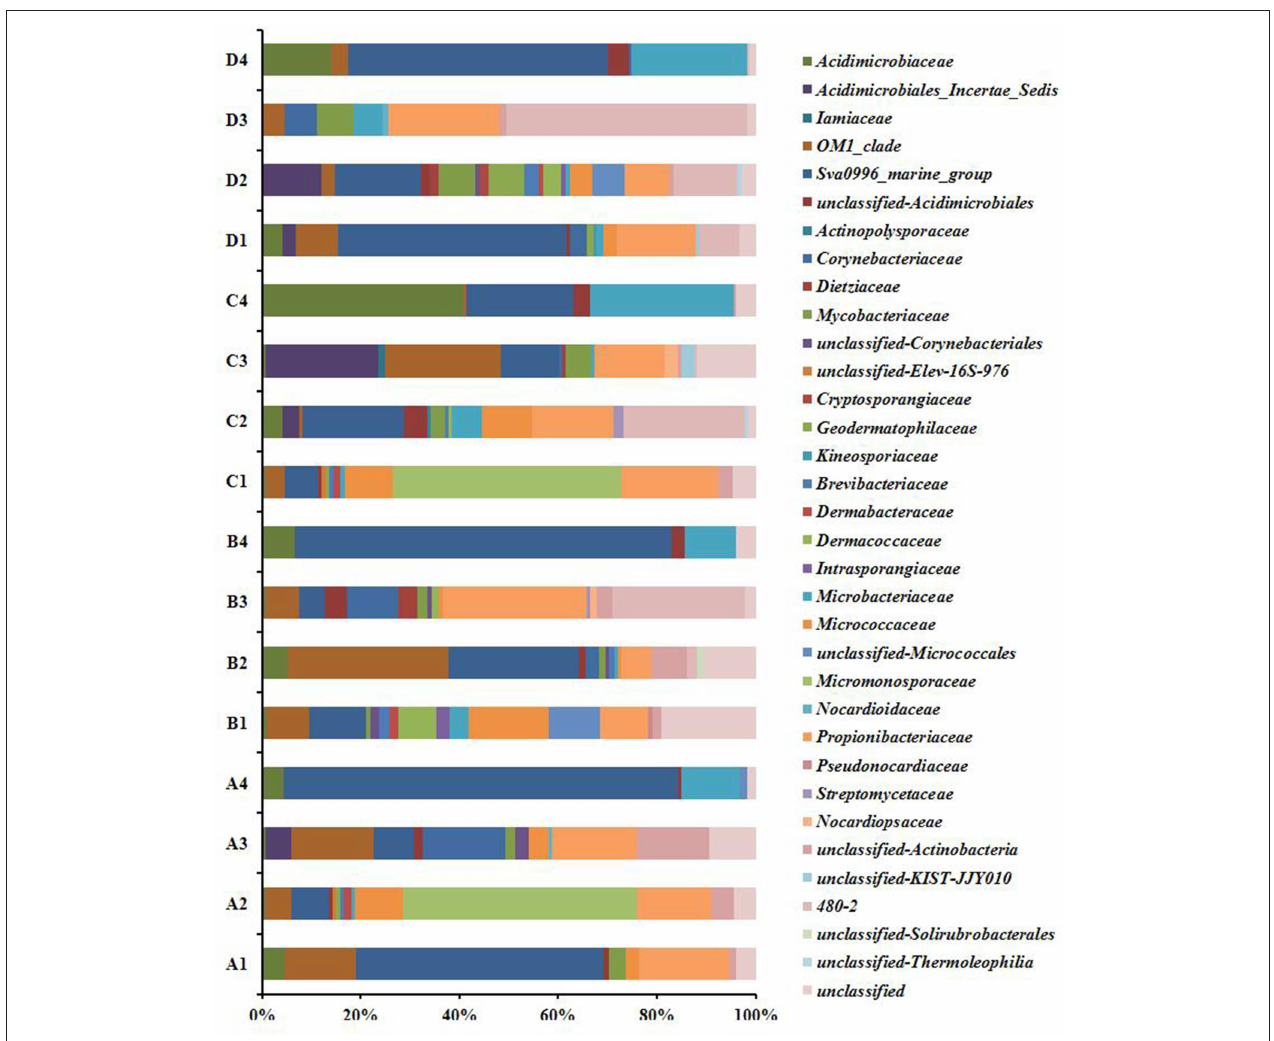
FIGURE 2 | Actinobacteria composition profiles. Taxonomic classification of actinobacteria sequences in to family identified by using the classify.seqs command in Mothur using Silva reference alignment database (http://www.mothur.org/wiki/Silva_reference_files, Release 119) with a confidence level of 80% were applied for classification. A1, mucus in February; A2, tissue in February; A3, skeleton in February; A4, seawater in February; B1, mucus in May; B2, tissue in May; B3, skeleton in May; B4, seawater in May; C1, mucus in August; C2, tissue in August; C3, skeleton in August; C4, seawater in August; D1, mucus in November; D2, tissue in November; D3, skeleton in November; D4, seawater in